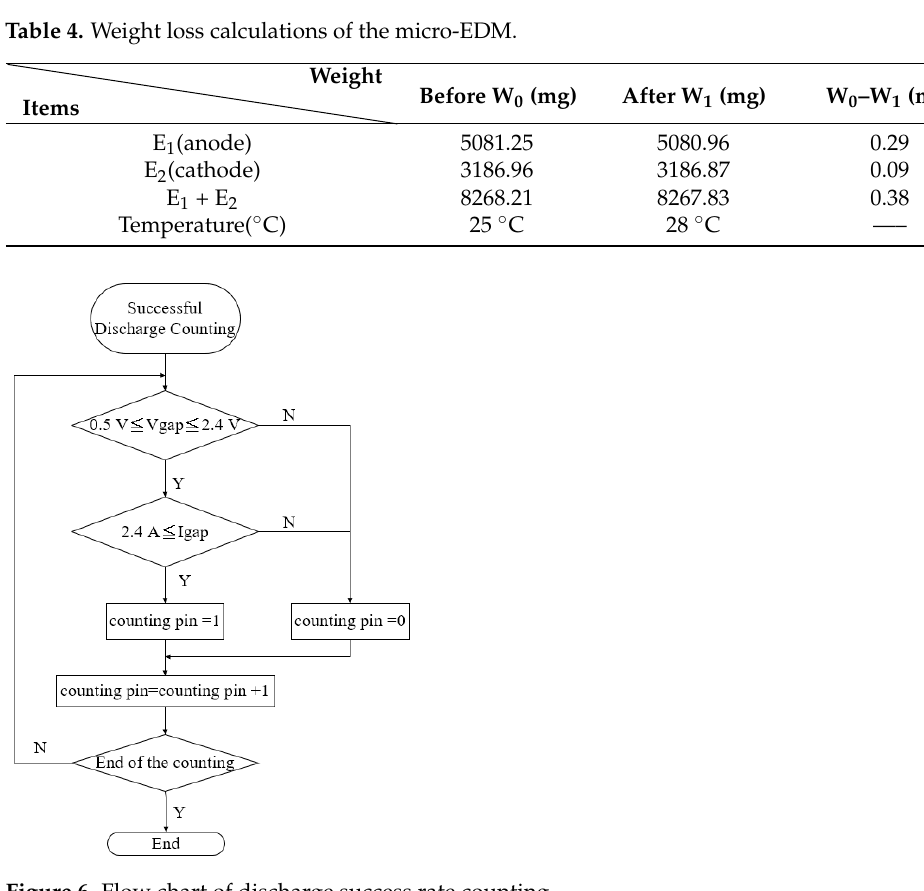
Figure 7. VisSim monitoring of the wave pattern.